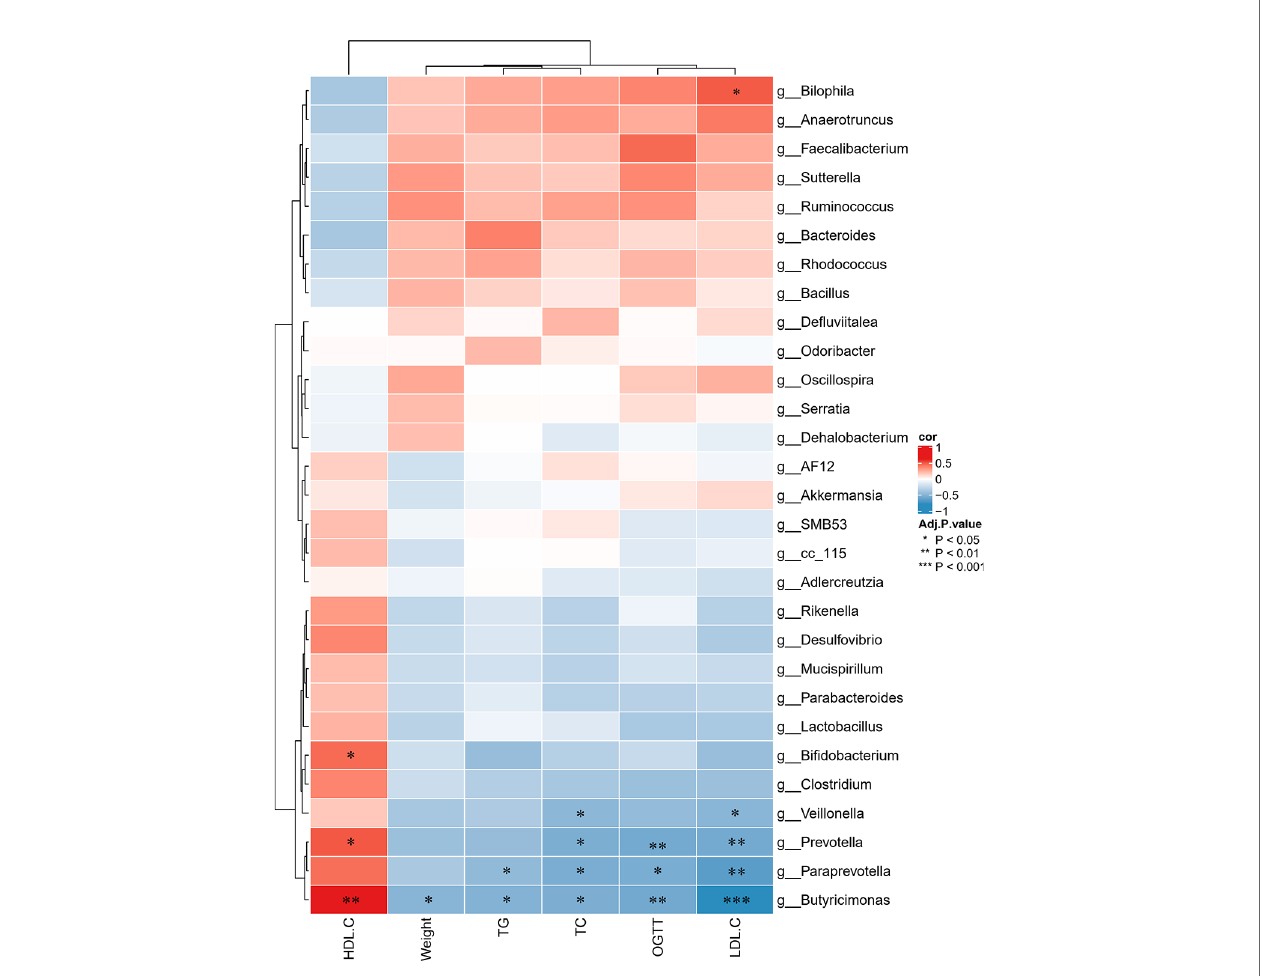
FIGURE 11 | Spearman correlations between glycolipid metabolism indices and microbes at the genus level in the four groups of mice. Red indicates high values; blue indicates low values. Data are expressed as the mean ± SEM, n = 9 for the CRP group and n = 10 for the other groups. *P < 0.05, **P < 0.01, ***P <